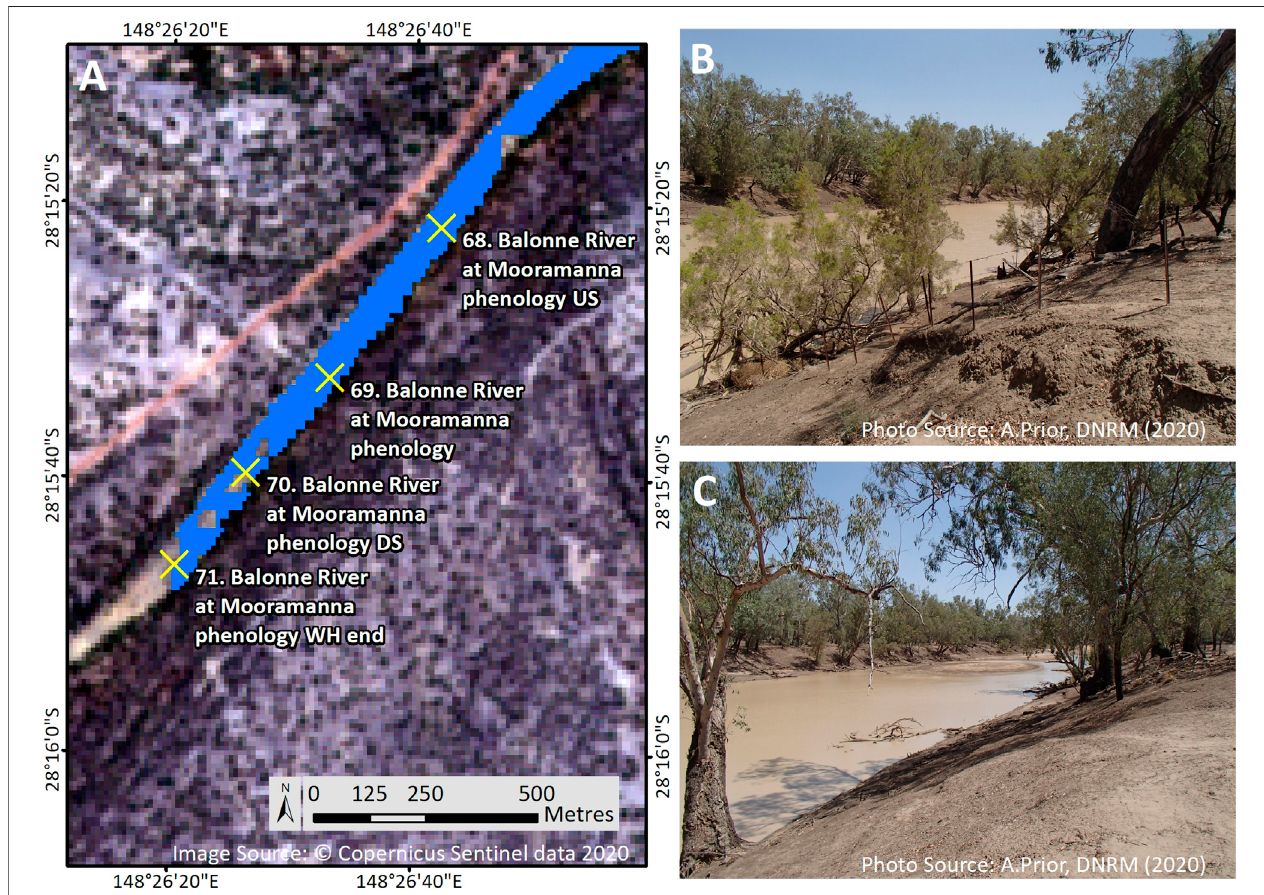
FIGURE 2 | The presence or absence of water in rivers of the QMDB was used to calibrate the accurate identi fi cation of water from satellite images (A) . As an example, the two site photos here represent sites 70 (B) and 71 (C) on the calibrated remote sensed water data.